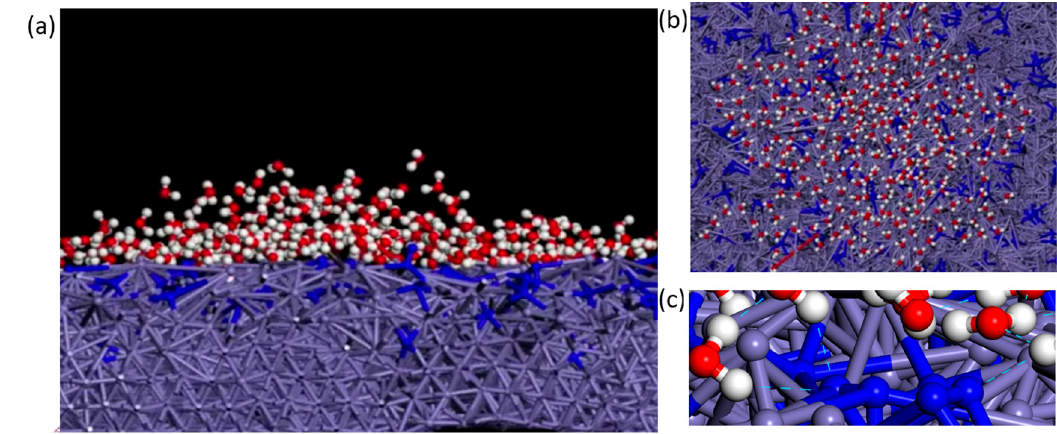
Figure 14. Wetting behavior simulation results: ( a,b ) superhydrophilicity of iron surface with plasma treatment, ( c ) hydrogen bond between N atom and water molecule.